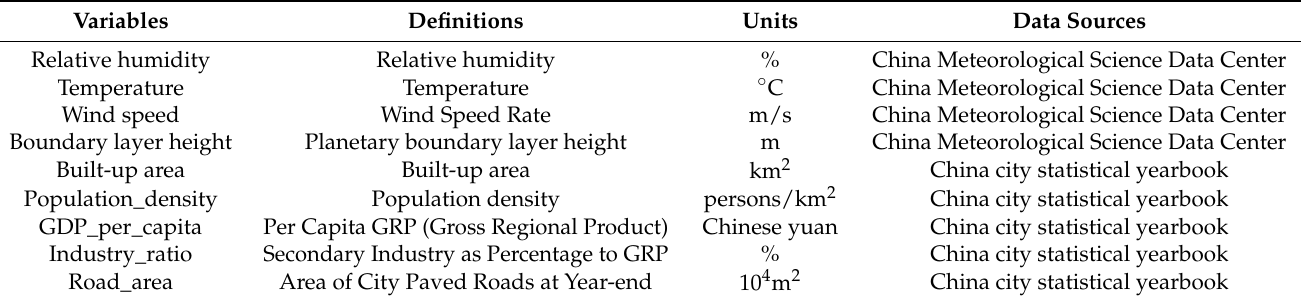
Table 1. Data sources for influencing factors used for influencing factor